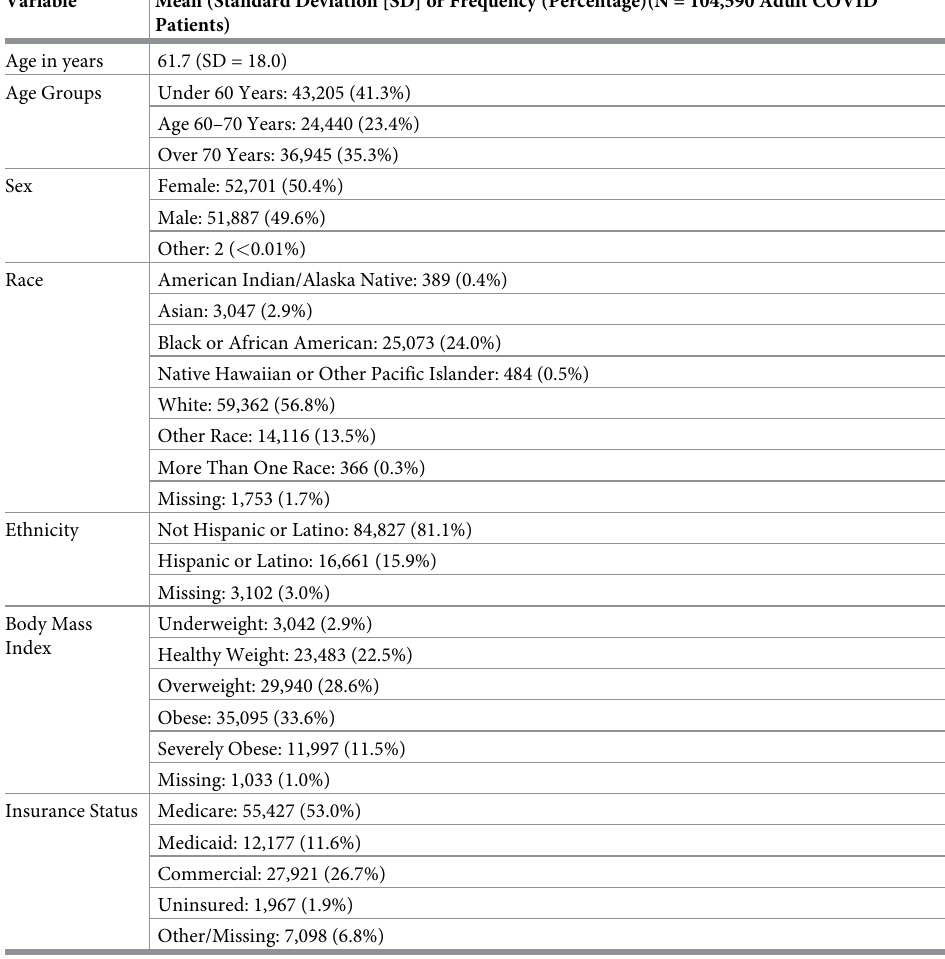
Table 1. Descriptive statistics for 104,590 hospitalized COVID–19 patients from February 2020 to September 2021.